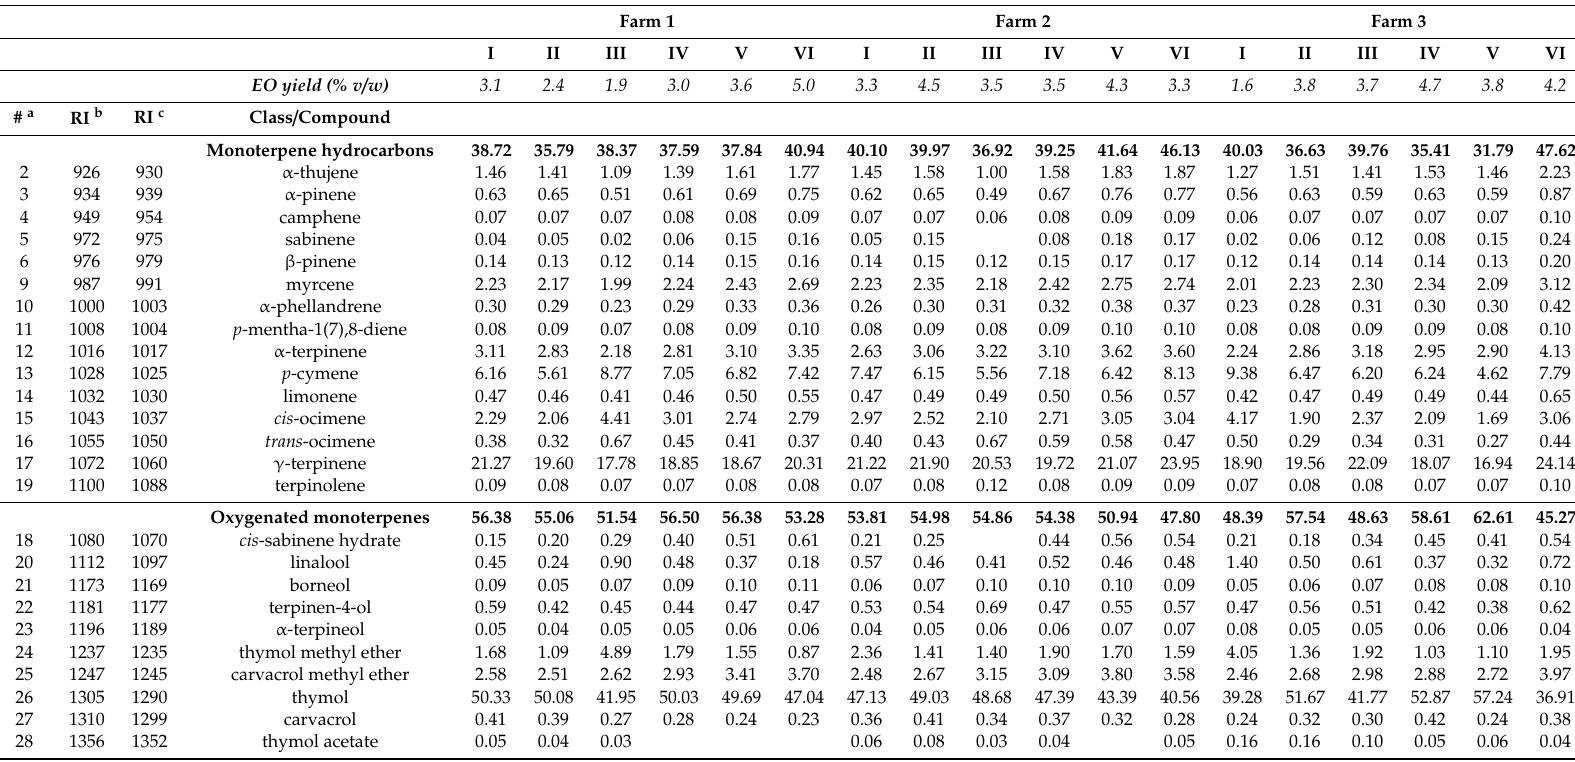
Table 1. Origanum heracleoticum . 2013. Essential oil (EO) yield and composition (relative peak area percent) in plants cultivated in 3 Sicilian farms (1 to 3) in 6 harvest times (I to